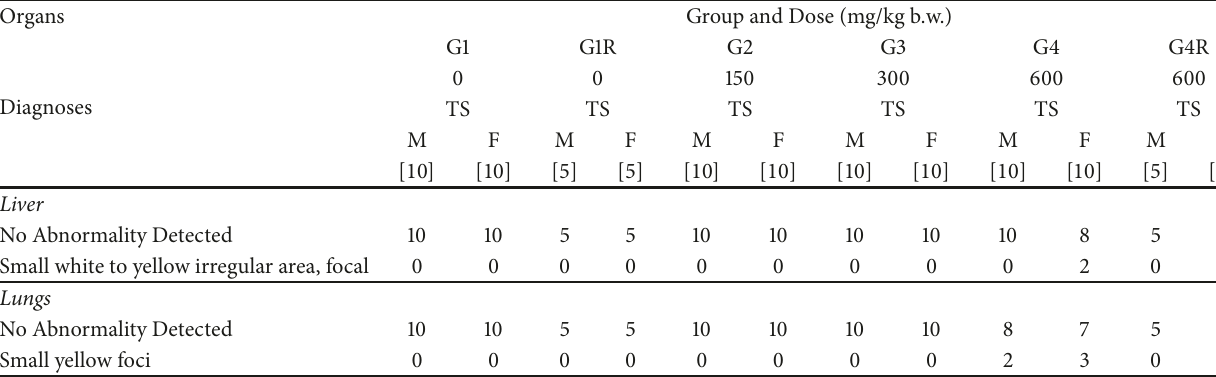
Table 13: Summary of gross necropsy findings, males and females.